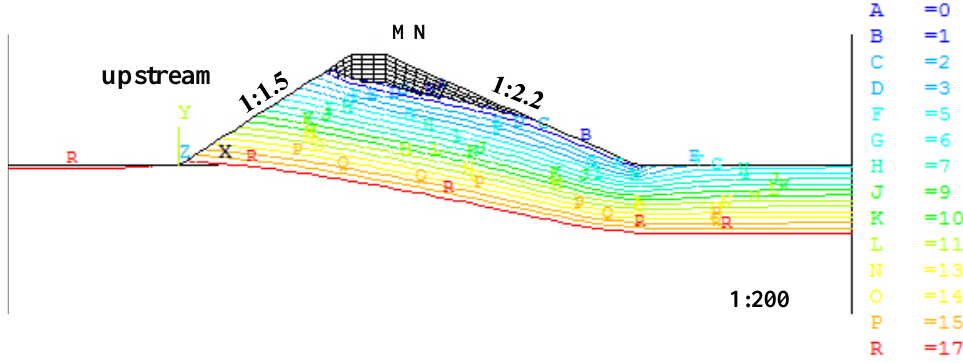
Figure 2. Calculation result for seepage.